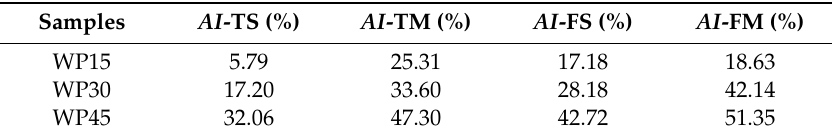
Table 2. The values of AI for di ff erent mechanical